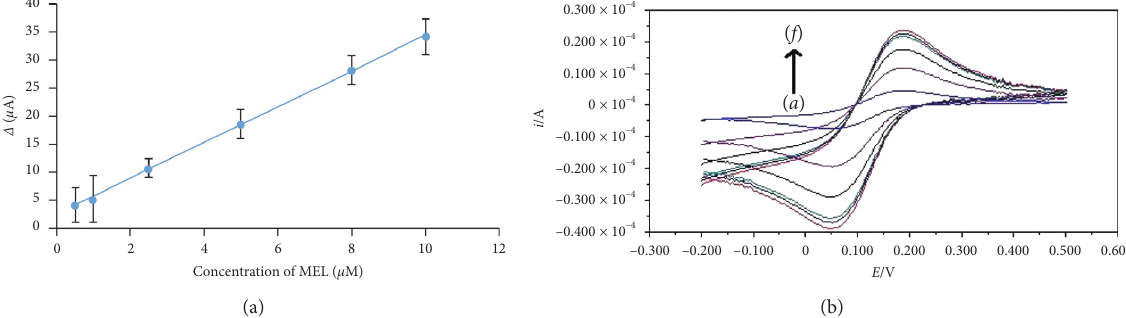
Figure 4: (a) The calibration curve of MEL in different concentrations and (b) the cyclic voltammograms of the MIP/GO-Fe electrode after loading in different solutions ( a : 8 μ M, b : 5 μ M, c : 2.5 μ M, d : 1 μ M, e : 0.5 μ M, and f : 0.1 μ M) of MEL in 0.3M probe